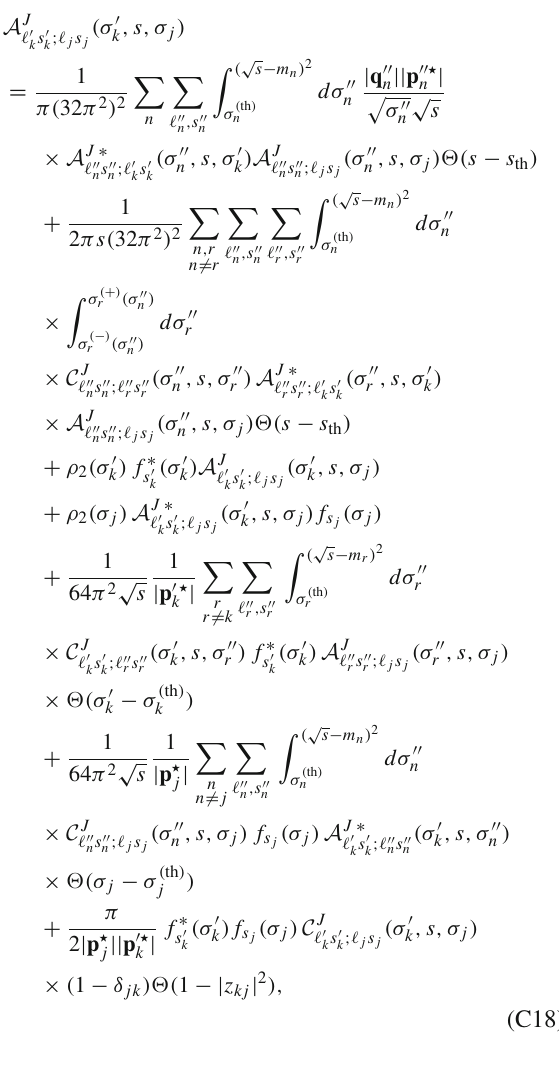
Combining all of this together yields the PWIS unitarity